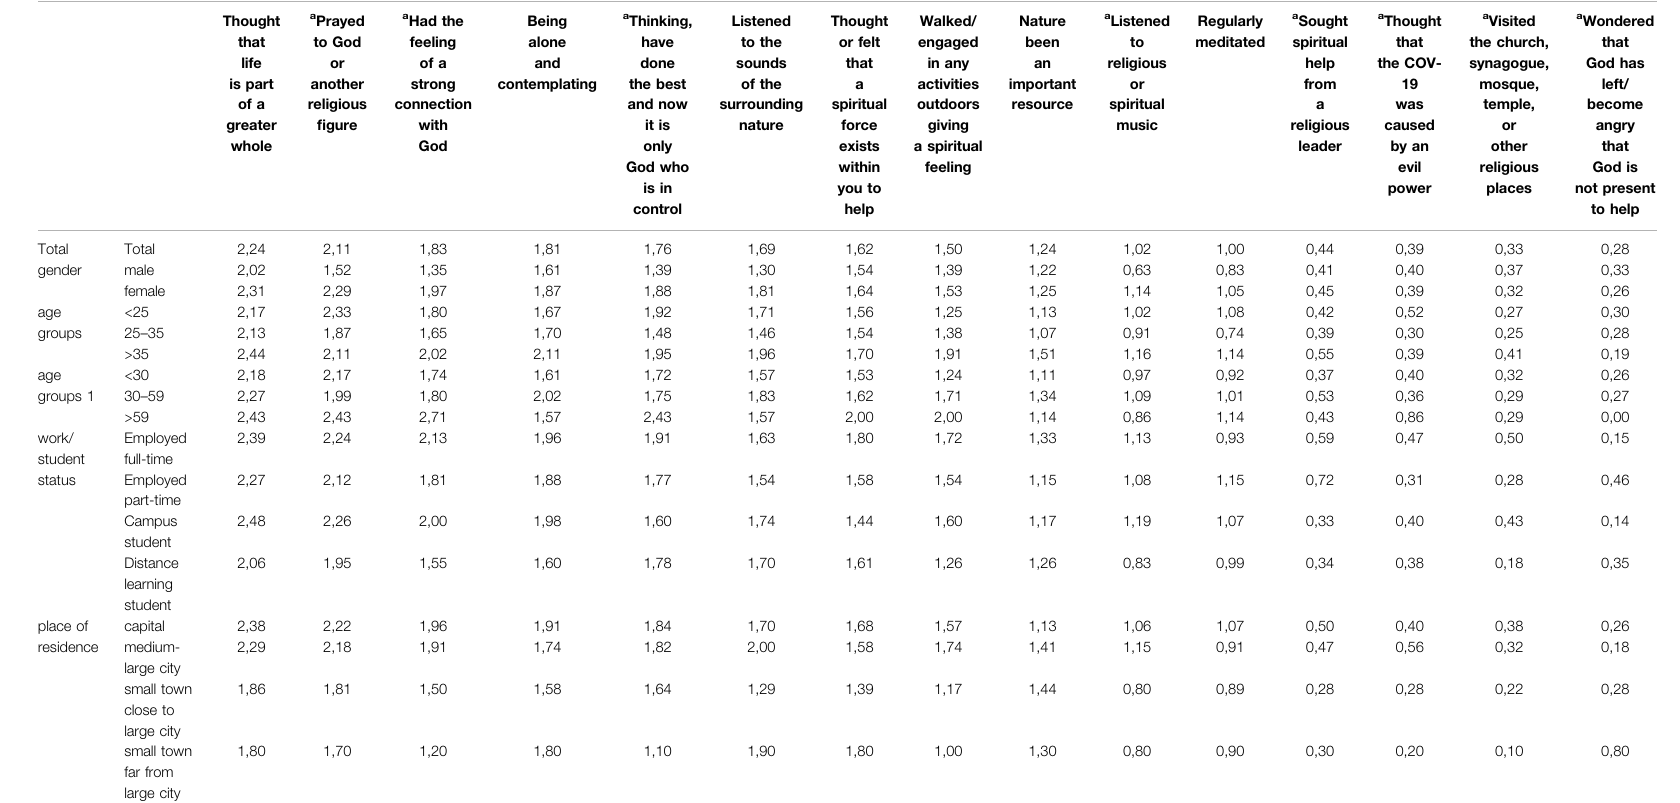
TABLE 3 | Vertical analysis comparing meaning-making coping methods, by